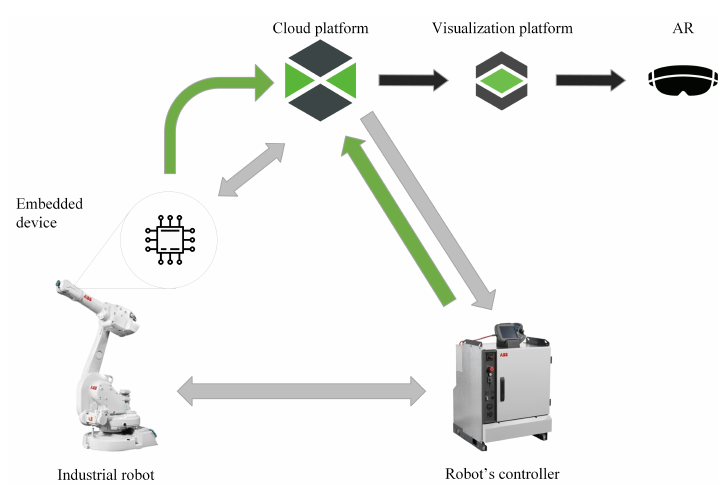
Figure 10. This figure shows how the data flow in the entire system. The data flow from two sources, where one of them uses the embedded device, which was developed for this purpose. The diagram shows the paths for the data flow containing the monitored parameters (green arrows) and paths for the data containing the control information (grey arrows). The black arrows, then, show the path for the data that are